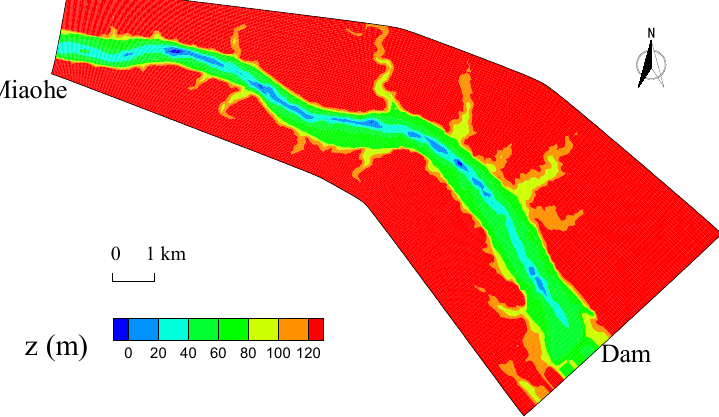
Figure 6. Observed bed elevation near the Three Gorges Dam (June 2003).